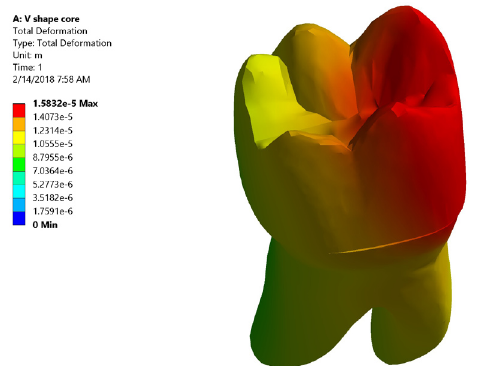
Figure 11. Color graphics showing safety factor of Group II.